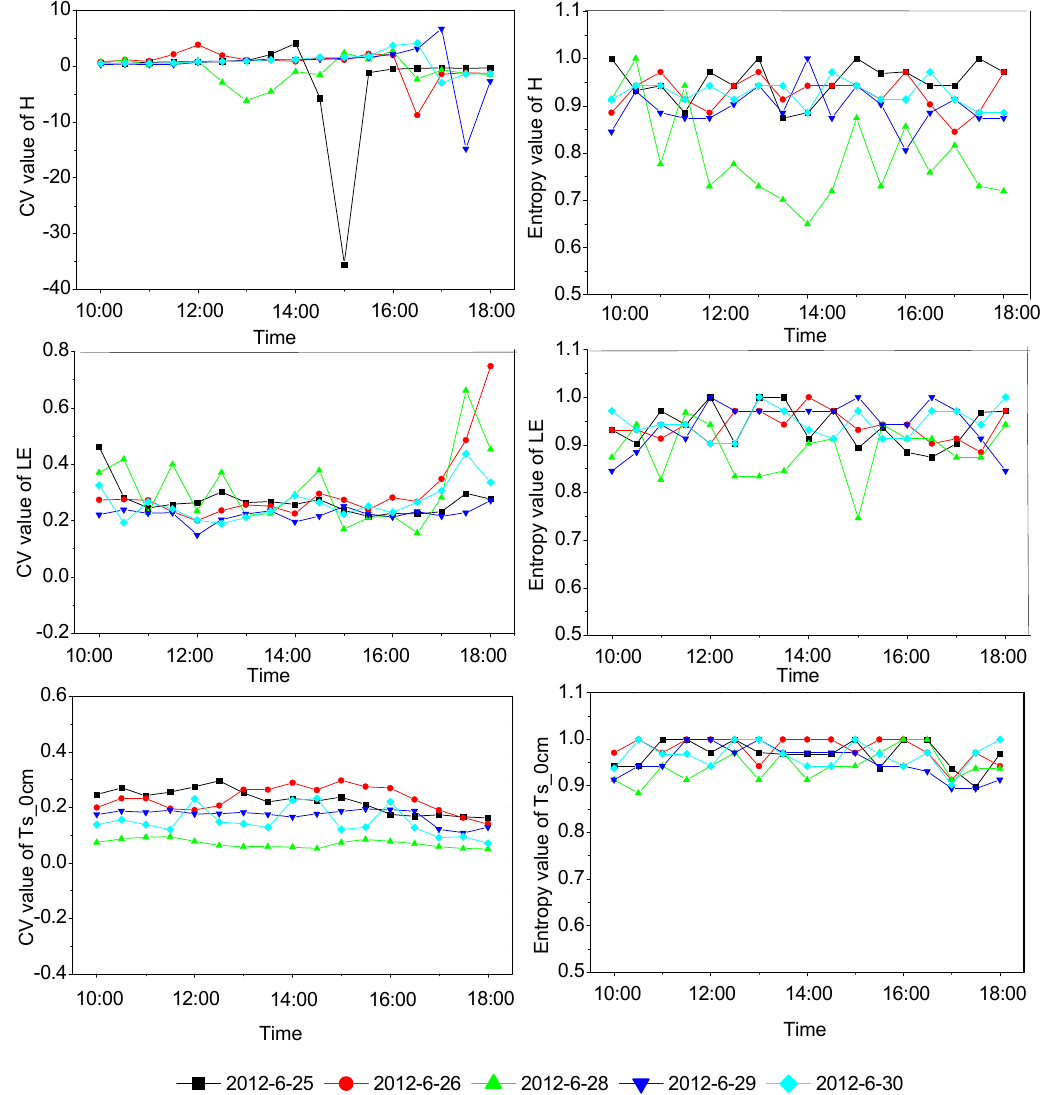
Figure 8. Temporal variation of the entropy and CV of surface variables (i.e., H, LE and Ts_0cm).